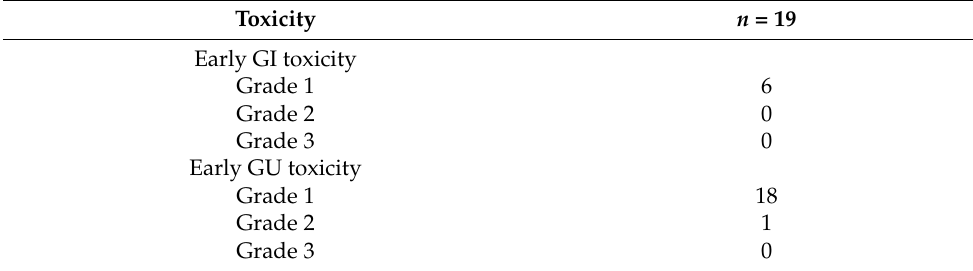
Table 2. RT-related acute and late